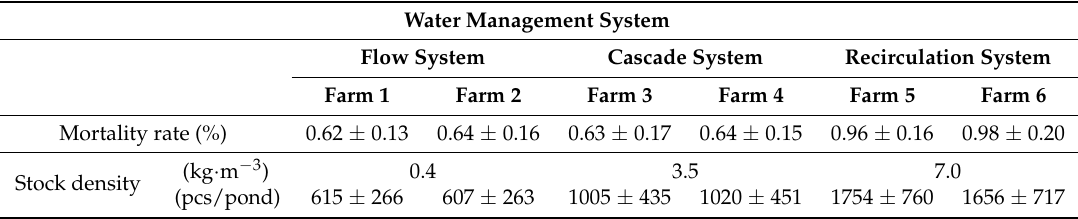
Table 4. Mortality rate of rainbow trout (%).